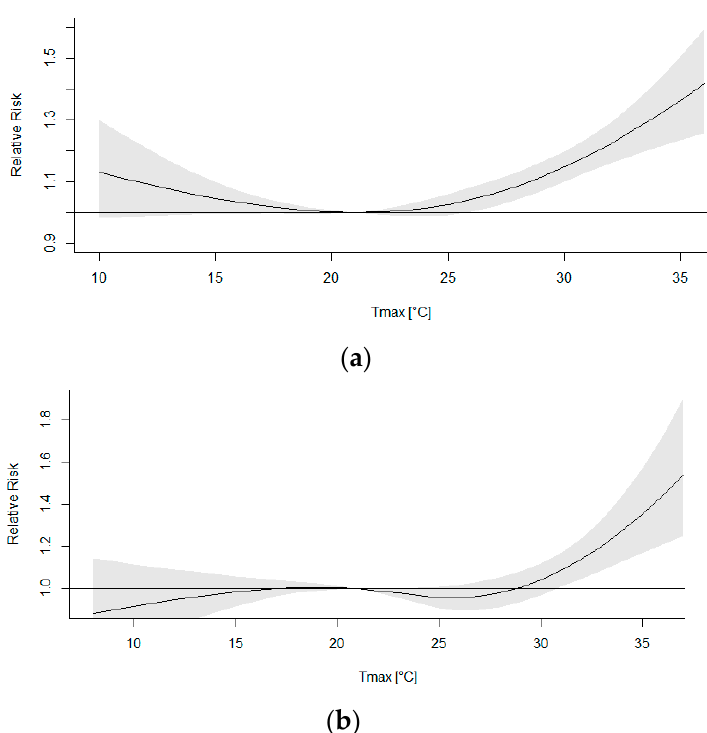
Figure 5. Relation between daily maximum temperature and relative mortality risk (all non-accidental causes) in warm months (June–September) for towns with population of 50–150 thousand during 2001–2016: ( a ) Wielkopolska; ( b ) Ma ł opolska.